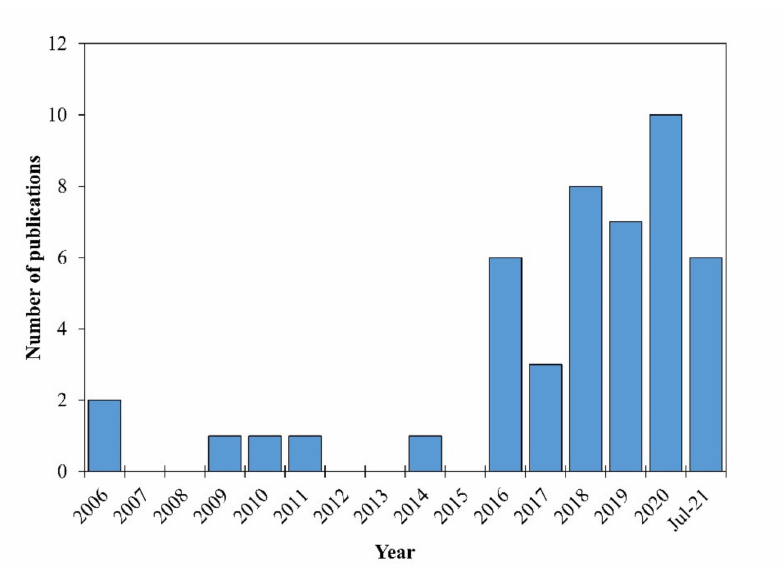
Figure 1. Tribological properties of high-entropy alloy ingots publication